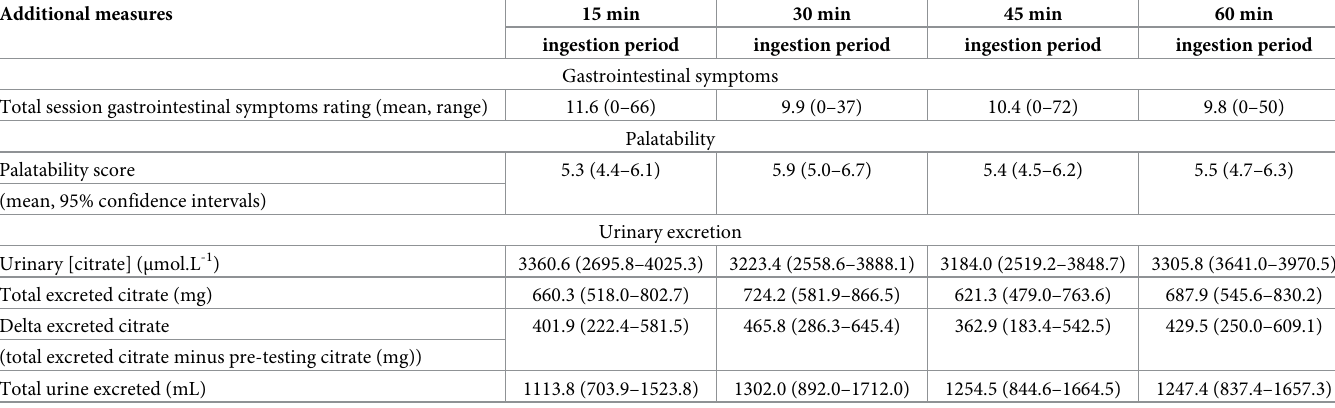
Table 4. Gastrointestinal symptoms (rating, n = 16 participants), palatability (score, n = 16 participants) and urinary excretion values ( n = 8 participants) following ingestion of 500 mg.kg -1 BM sodium citrate over 15, 30, 45 or 60 min.